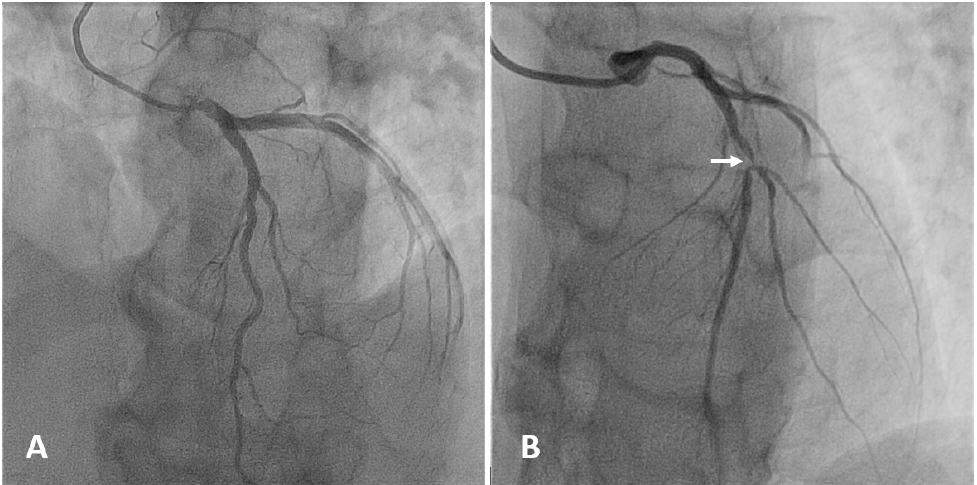
Figure 4. Selective angiography of the left coronary artery. ( A ) Normal coronary anatomy: left main, left anterior descending (LAD), left circumflex, and their branches are patent. ( B ) Focal severe narrowing of the lumen (arrow) due to a 90% stenosis in the proximal segment of the LAD. 5.2. Intravascular Ultrasound (IVUS) and Optical Coherence Tomography (OCT) IVUS and OCT allow direct cross ‐ sectional visualization of the coronary wall and are now considered the gold standard for in vivo imaging of coronary calcification [79,100,103]. IVUS imaging is based on ultrasound reflection by coronary calcification and is more sensitive and specific than angiography (Figure 5). Compared to OCT, IVUS has lower spatial resolution and greater penetration depth, thus provide good assessment of the entire arterial wall. However, IVUS cannot penetrate calcium, hence its assessment of plaque calcification is quantitatively expressed as arc (in degrees) and length. Calcified plaques appear echo ‐ dense (hyperechoic) and brighter than the surrounding adventitia. Some grey ‐ scale IVUS signal intensity features have been associated with histological features of plaque instability and high risk of CAD: plaque with ultrasonic attenuation (echo ‐ attenuated plaque), associated with fibroatheroma containing large necrotic core; echo ‐ lucent plaque, containing an intraplaque zone of absent echogenicity, correlated with small necrotic core; spotty calcification and calcified nodule, both associated with acute coronary events [104,105]. Figure 5. Intravascular ultrasound (IVUS) pull ‐ back in a symptomatic, diabetic female patient with a critical left main stenosis (A, right panel: IVUS frame corresponding to the dotted line A, left panel). Left anterior descending (LAD) presents the diffuse disease with calcific eccentric lesion (triangle arrows B and C right panel, corresponding to the dotted lines B and C left panel). Behind calcifications, shadow does not allow us to obtain complete vessel contours. However, the grey ‐ scale atheromatous plaque classification is limited by the IVUS axial and lateral resolution (about 200 microns), not sufficient to visualize some components of the vulnerable